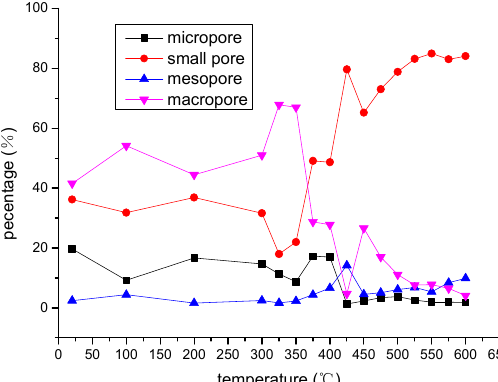
Figure 7. The percentage of different groups versus temperature of the first group samples.